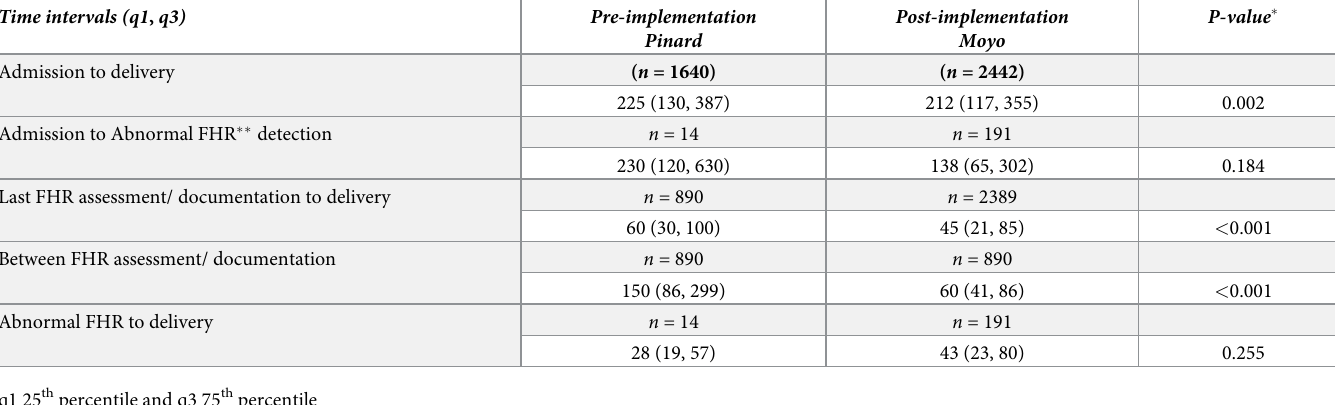
Table 3. Comparison of different median time intervals pre- and post-implementation of the Moyo at Temeke � . Time intervals (q1 ,